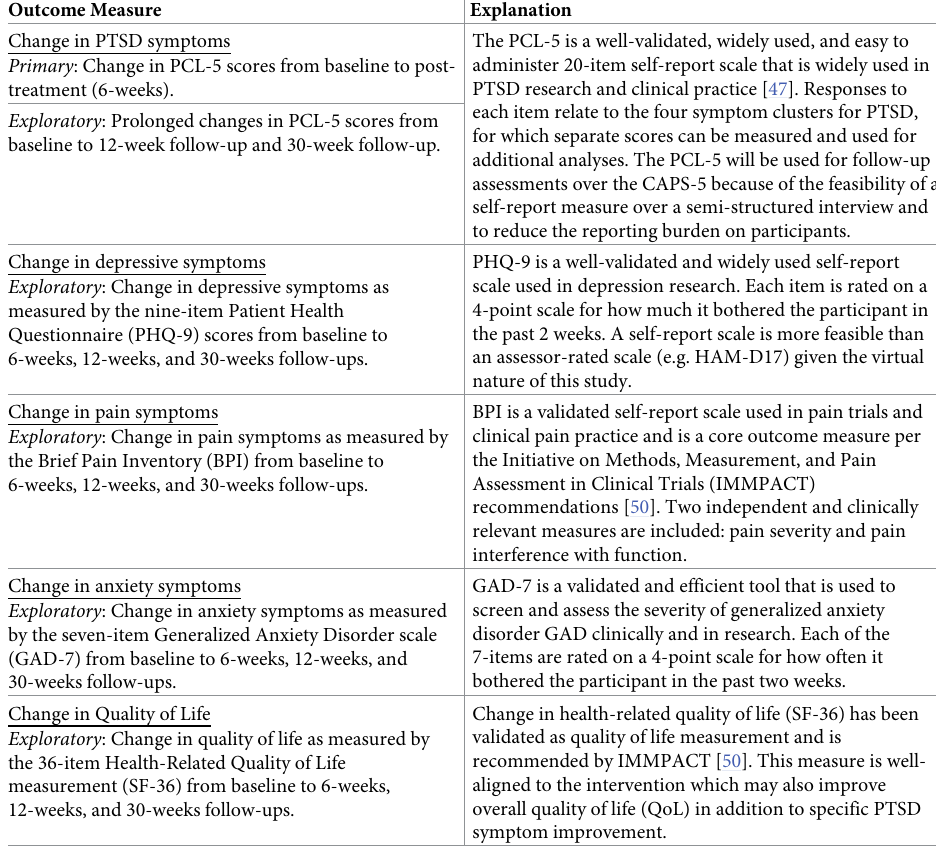
Table 4. Primary and exploratory outcome measures for the effectiveness